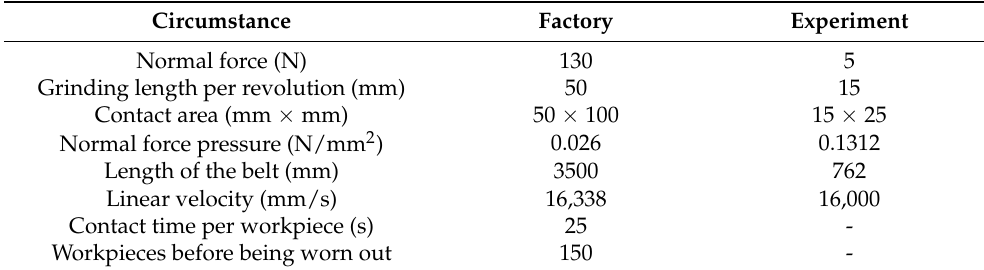
Figure 10. The setup to systematically prepare the abrasive belts with different degrees of wear. Table 2. Comparison of the grinding parameters in a factory setting and in this